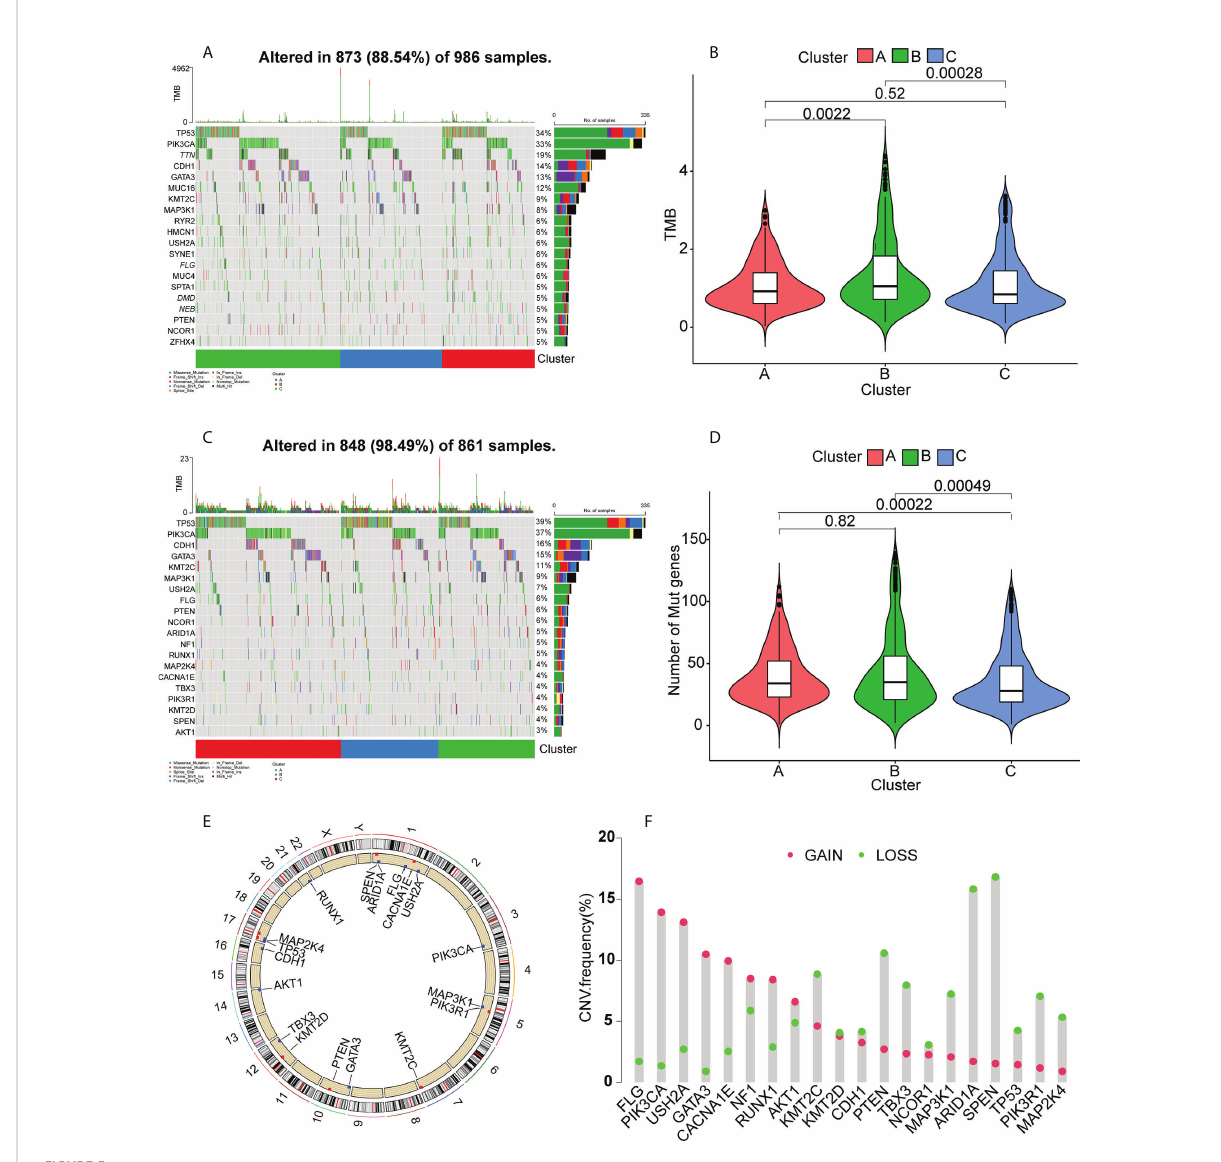
FIGURE 5 Gene mutation landscapes in the clusters. (A) Top 20 mutated genes in all clusters. (B) Tumor mutation burdens. (C) Top 20 mutated tumor- driver genes. (D) Tumor mutation burdens. (E) Chromosomal localizations of mutated tumor-driver genes. (F) CNV changes in mutated tumor- driver genes. Red dots represent increased CNV; green dots represent decreased